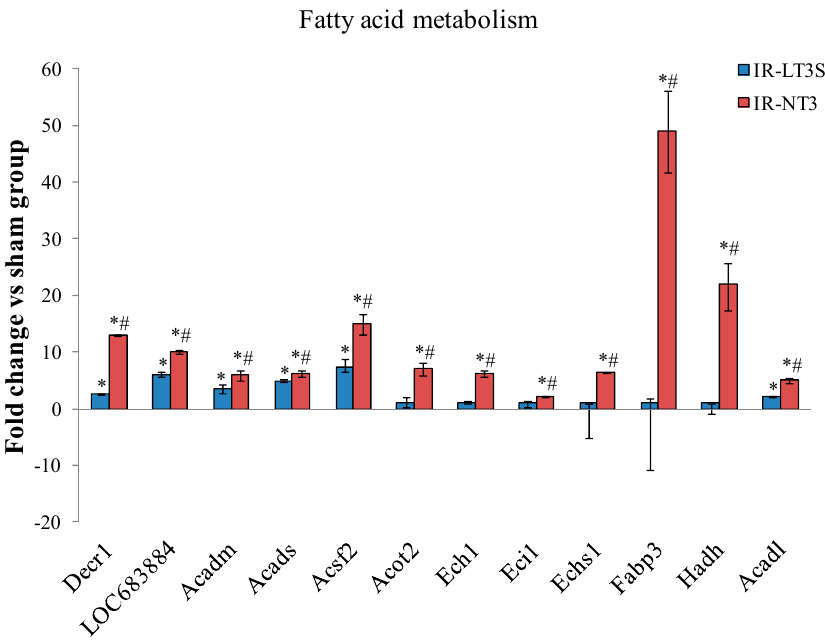
Figure 4. Differentially expressed proteins involved in TCA cycle and pre TCA cycle. Data are expressed as median and interquartile range. * p vs. sham < 0.017; # p vs. IR-LT3S < 0.017. Protein acronyms are listed in the abbreviation list. Similarly to pre-TCA and TCA, IR induced an increase of protein subunits involved in fatty acid metabolism (Figure 5). The highest levels were found in IR-NT3 rats and the most highly expressed isoforms were involved in: (1) β oxidation and lipid biosynthesis (2,4-dienoyl CoA reductase 1, Decr1; acetyl-coenzyme A dehydrogenase medium and short chain, Acadm and Acads;